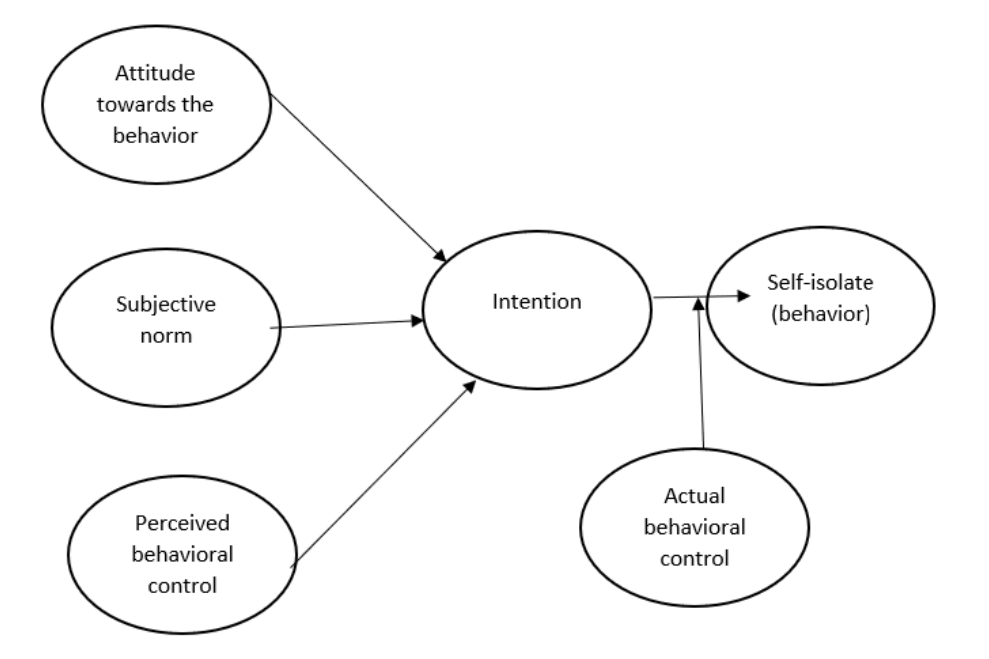
Figure 1. Conceptual model.